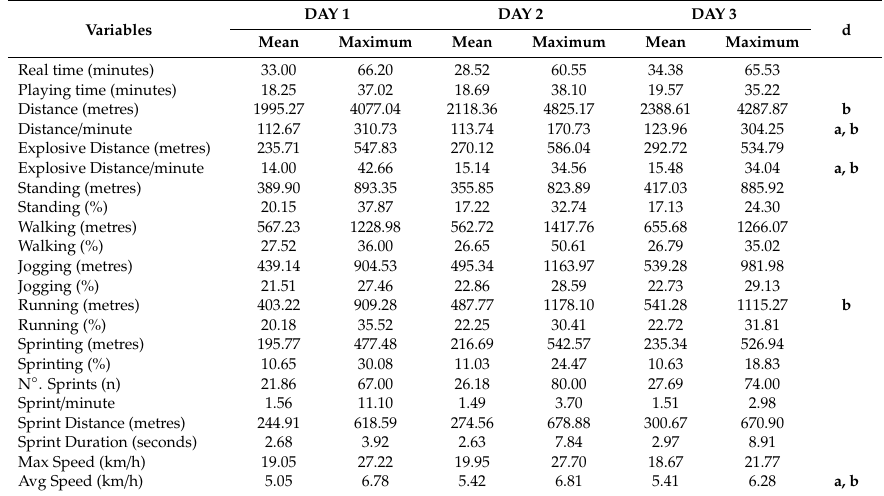
Table 2. Descriptive results by match day.